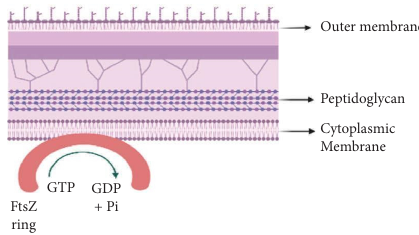
Figure 1: Divisome with FtsZ protein [10].